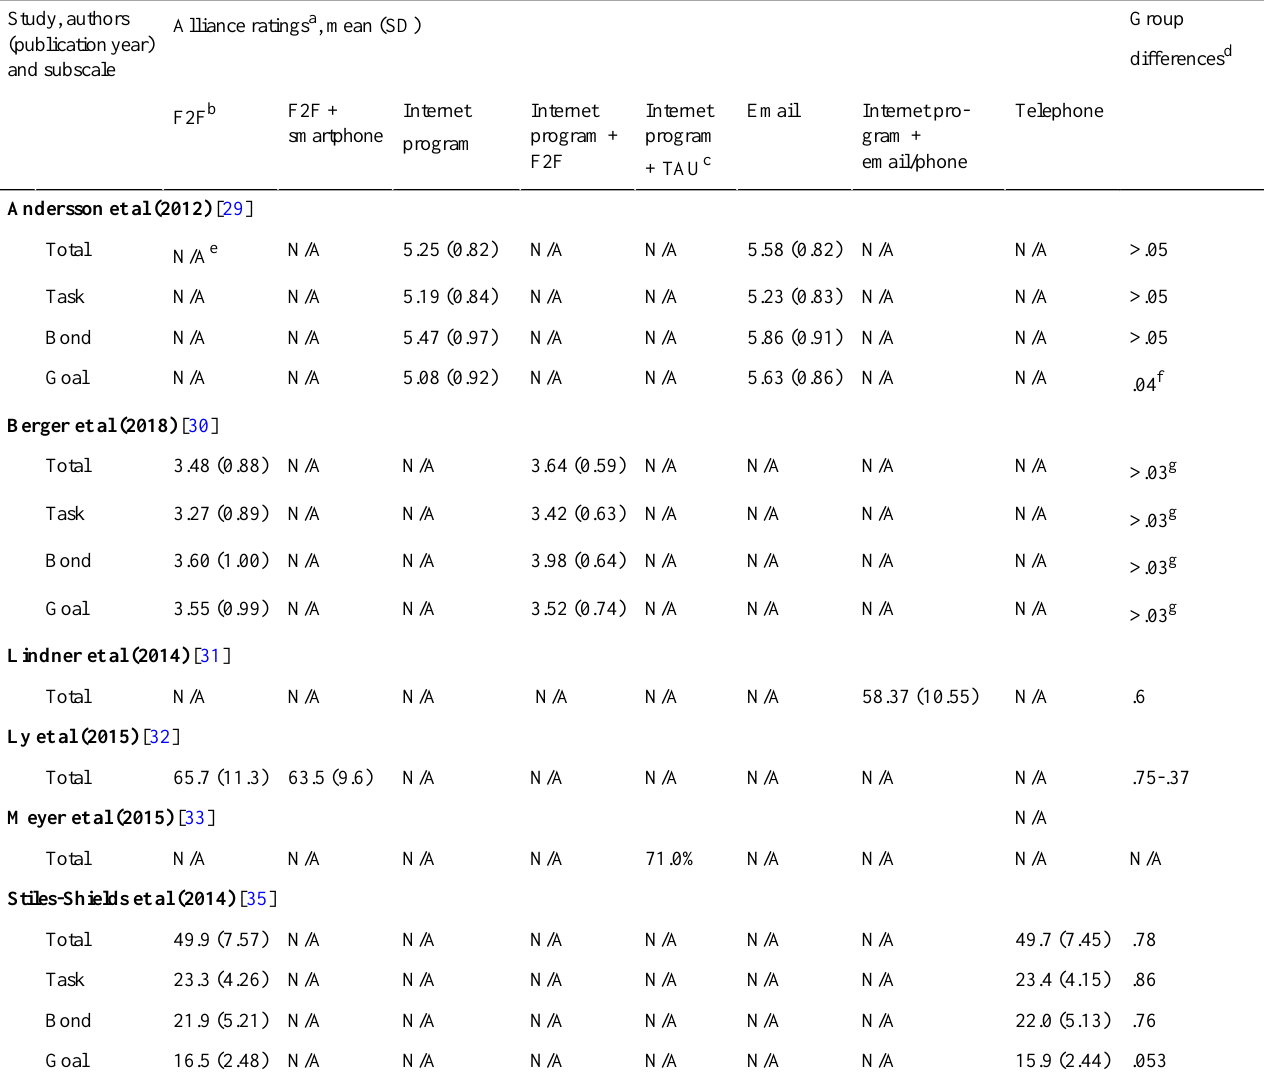
Table 4. Patients’ratings for therapeutic alliance.